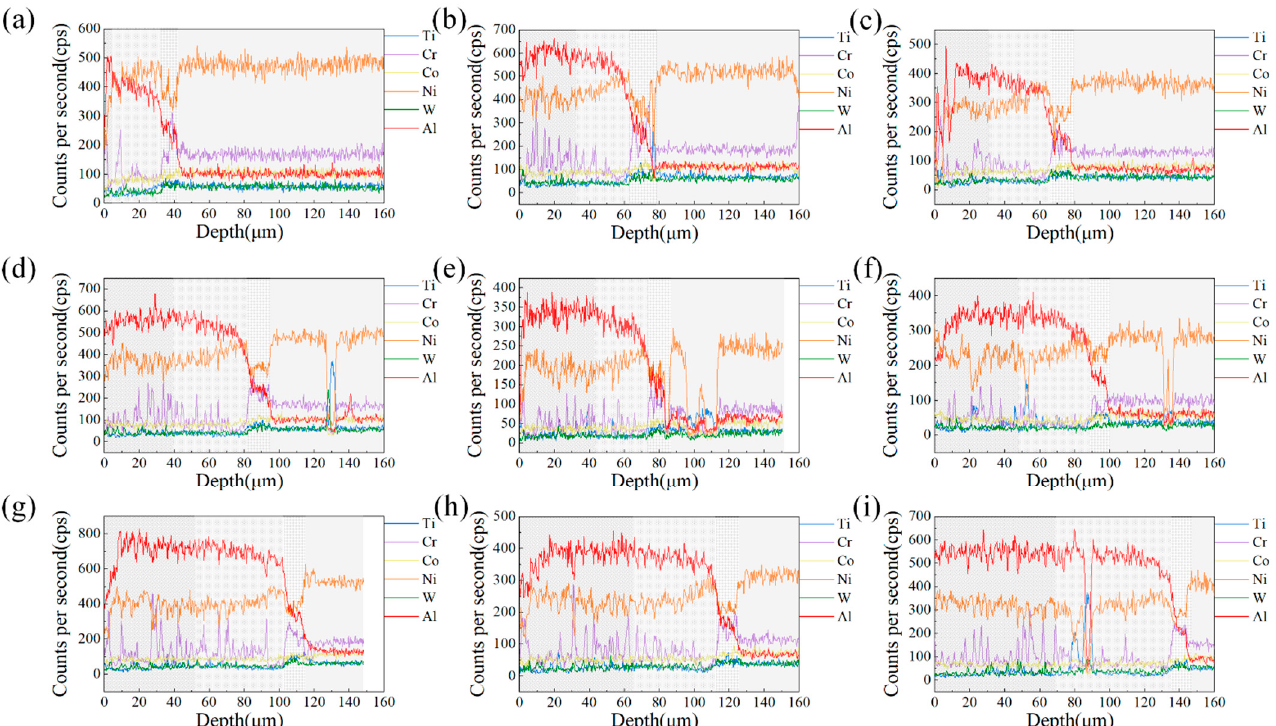
Figure 5. The elements’ content variation along the coating depth direction. ( a – i ) represent specimens #1–9, respectively.